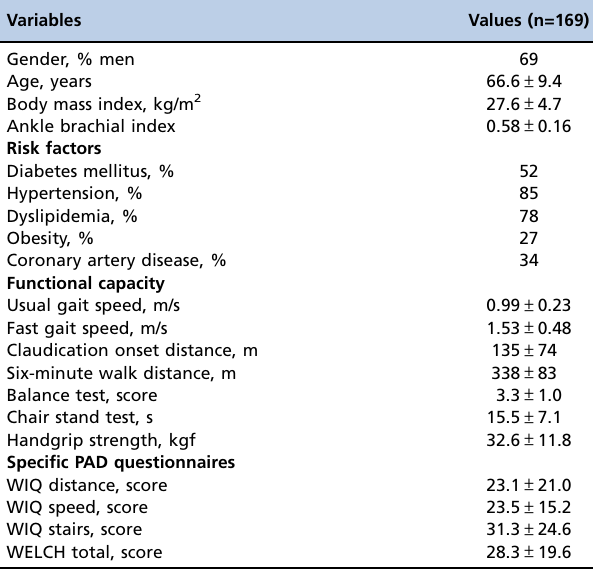
Table 1 - Characteristics of the intermittent claudication patients included in the study.